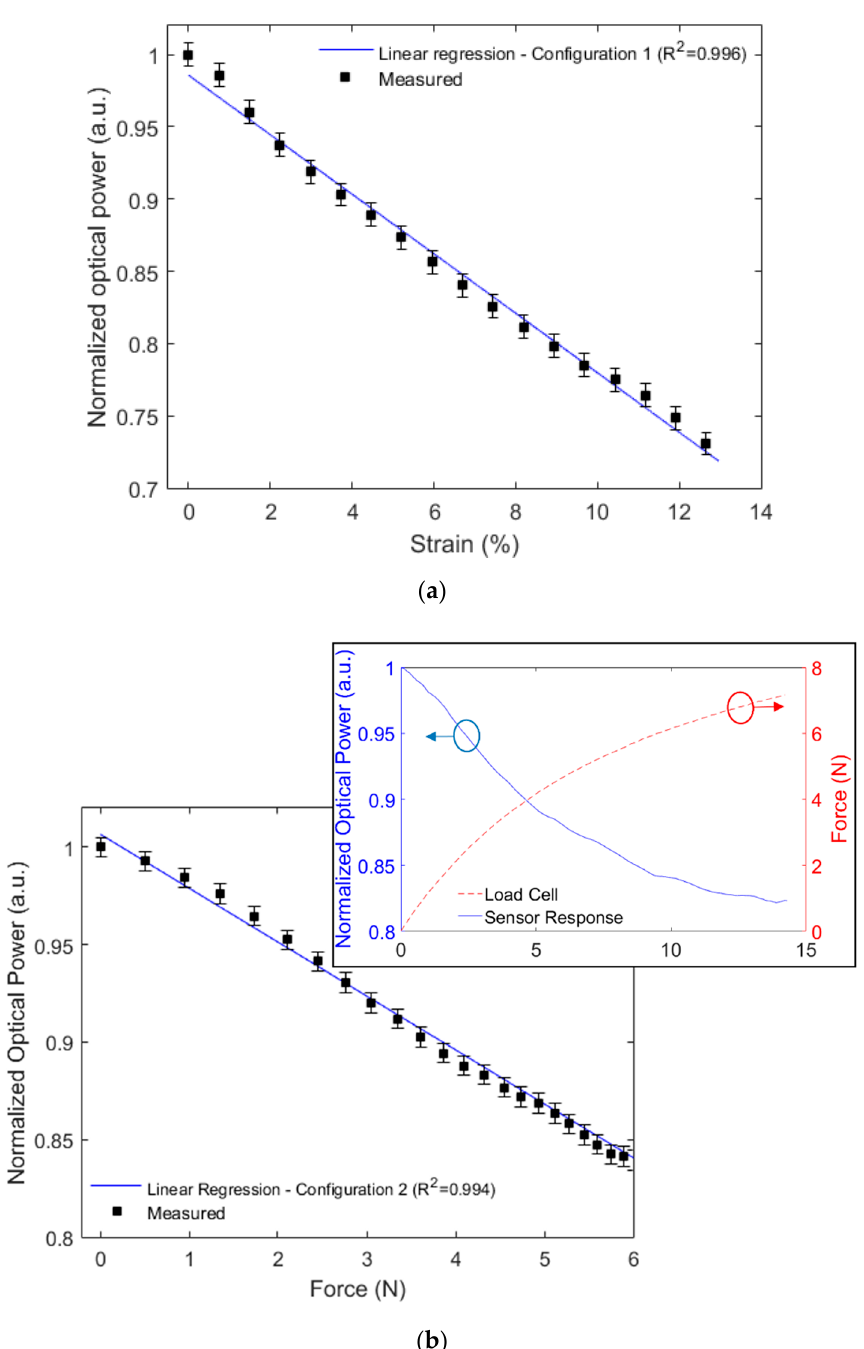
Figure 5. Normalized optical power as a function of ( a ) strain (configuration 1) and ( b ) force (configuration